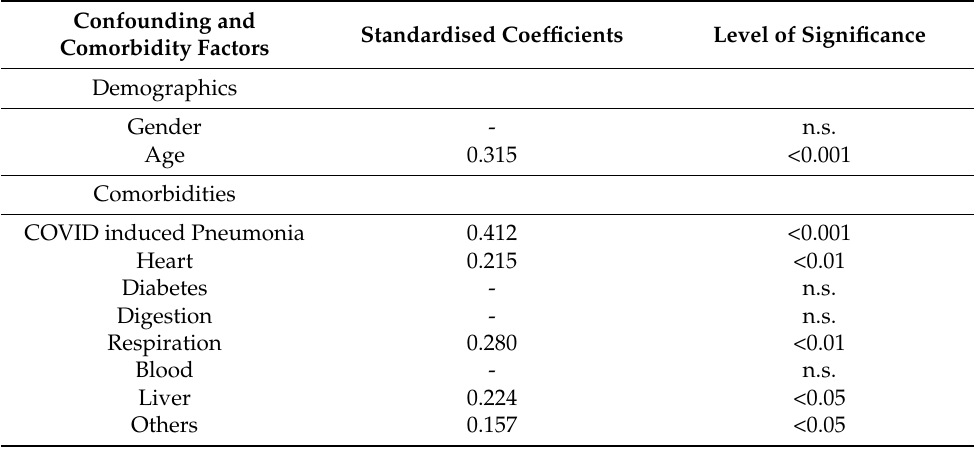
Table 5. Patients’ confounding factors and their relation to hospitalization